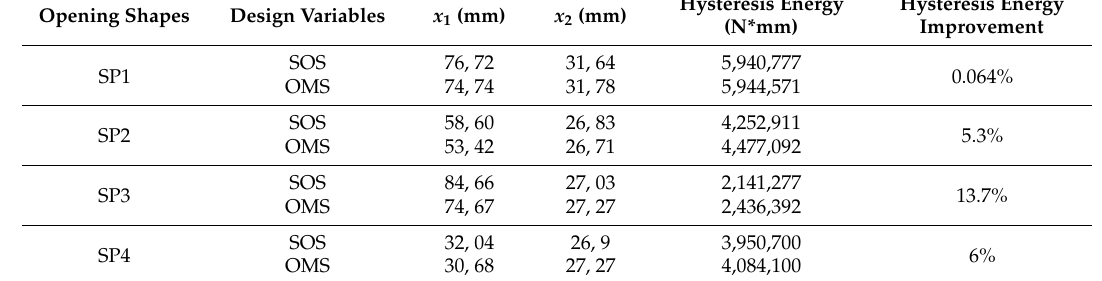
Figure 7. Hysteresis energy of four kinds of optimized coupling beam metal dampers. Table 1. Optimization results f or sample optimal solution (SOS) and optimization model solution (OMS).